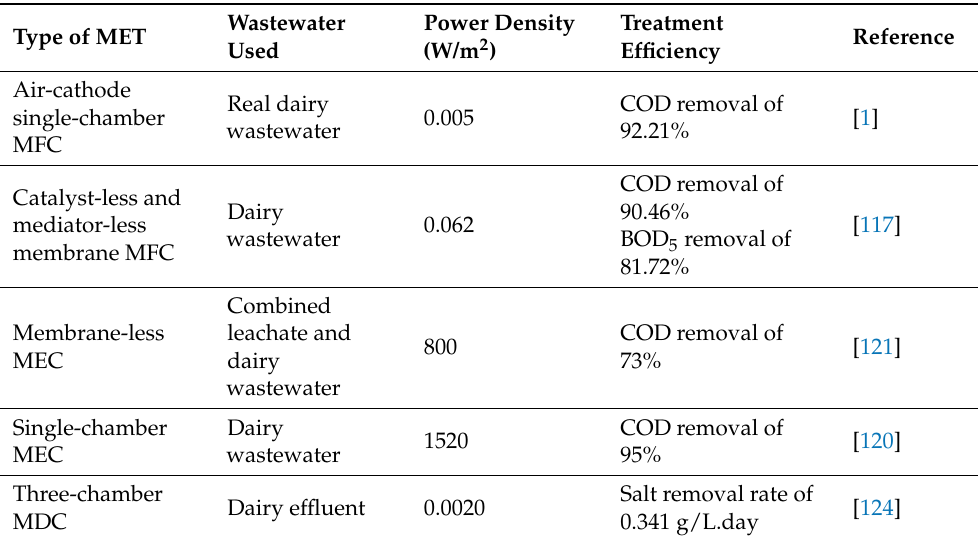
Table 4. Treatment of dairy wastewater using different